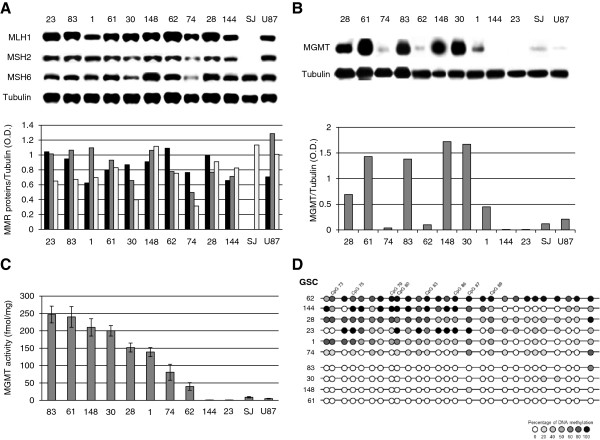
Analysis of MMR components and MGMT in GSC and GBM cell lines. Immunoblot analysis of MLH1 (black column), MSH2 (grey column), MSH6 (white column) (Panel A) and MGMT proteins (Panel B). Bar graphs represent the mean ratios between the optical densities (O.D.) of the protein of interest and those of tubulin. The results are representative of one out of two experiments with similar results. SJ: SJGBM-2. Panel C. Analysis of MGMT activity. MGMT activity is expressed as fmol of methyl groups per mg of total protein and data are the mean (± SD) of three independent experiments. Panel D. Analysis of MGMT promoter methylation. Summary of bisulfite sequencing in 10 GSC lines. A total of 27 CpG dinucleotides (CpGs) within the promoter region of MGMT were analyzed and are represented as circles. Each row refers to one individual cell line and circle color indicates the percentage of methylation of each CpG calculated on 15 clones analyzed for each cell line. Closed circles represent fully methylated cytosines, open circles represent fully unmethylated cytosines and grey scale circles represent the indicated percentages of DNA methylation. CpGs 73, 75, 79, 80 (i.e., CpG +95, +113, +135, +137, beginning the numbering at the transcription start site and according to Everhard et al.[25]) and CpGs 83, 86, 87, 89 correspond to those that best correlate with gene expression [27].